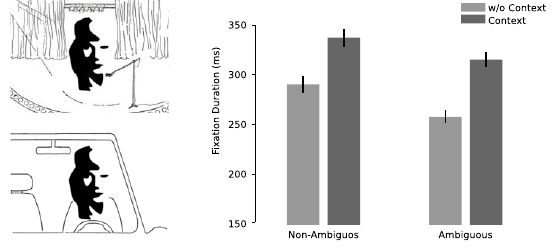
Figure 7. The influence of stimulus ambiguity and context on fixation duration. For every ambiguous stimulus, two contextual scenes were created, which were congruent with either percept of the ambiguous stimulus. In the example it is the silhouette saxophone player during a performance (left top), or a frontal view of a female car driver with light from the right (left bottom). Additionally, disambiguated versions of these stimuli were created. The average fixation duration is dependent on the main factor ambiguity as well as on the main factor context (right). Error bars depict